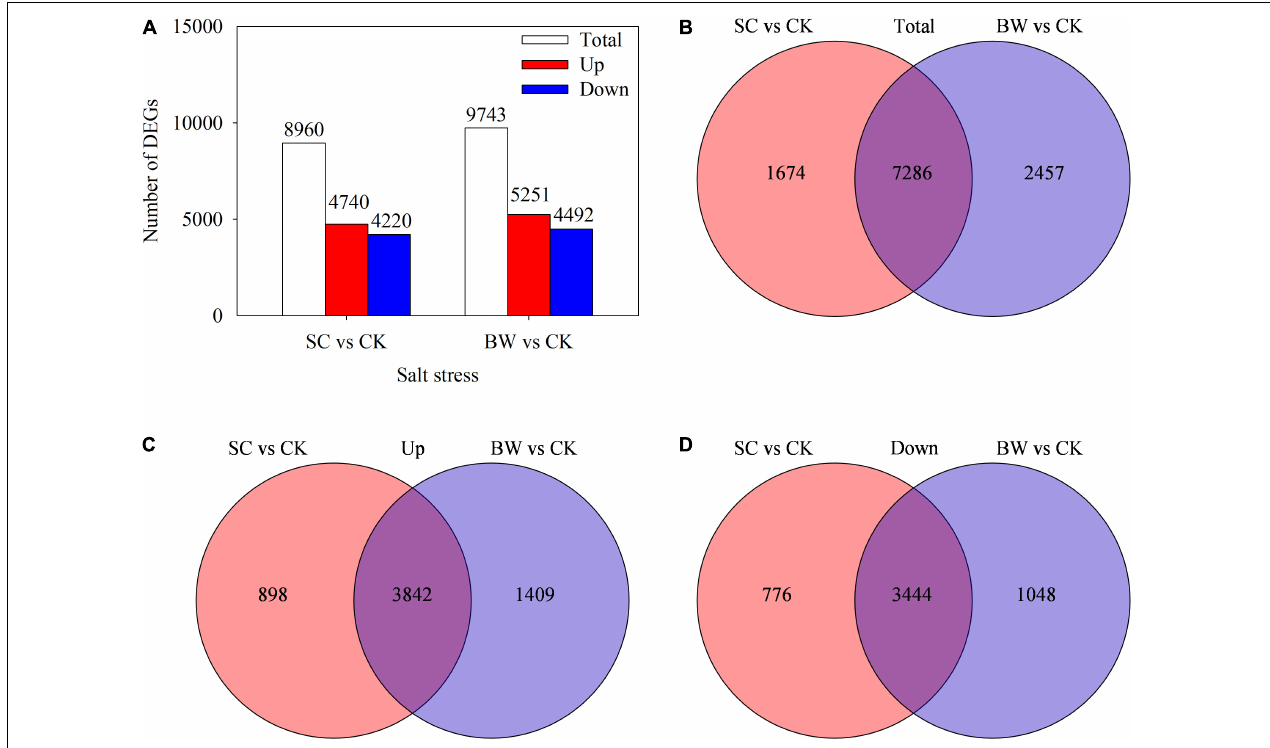
FIGURE 2 | Profiles of differentially expressed genes (DEGs) involved in the seed initial imbibition under salt stress. (A) Number of the total upregulated and downregulated DEGs with fold change ≥ 2. Venn diagram of (B) total, (C) upregulated and (D) downregulated